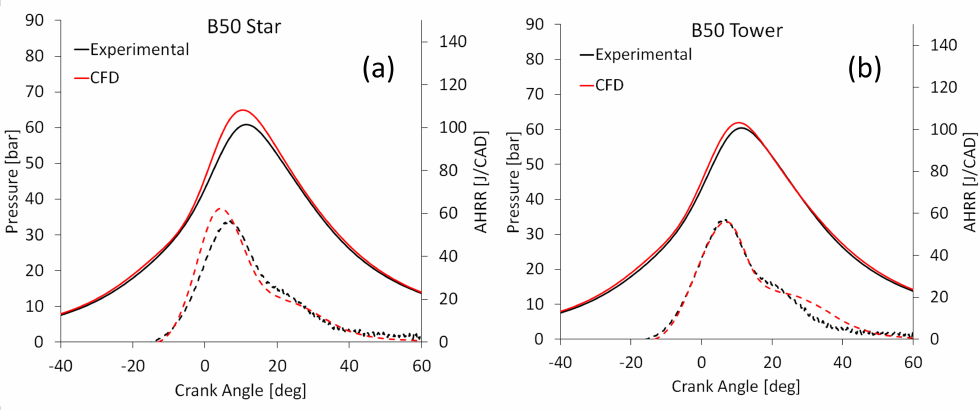
Figure 11. Comparison between the computed and experimental data of the in-cylinder pressure (solid lines) and apparent heat release rate (dashed lines) for the B50 operating point when using the star ( a ) and tower ( b ) pistons.